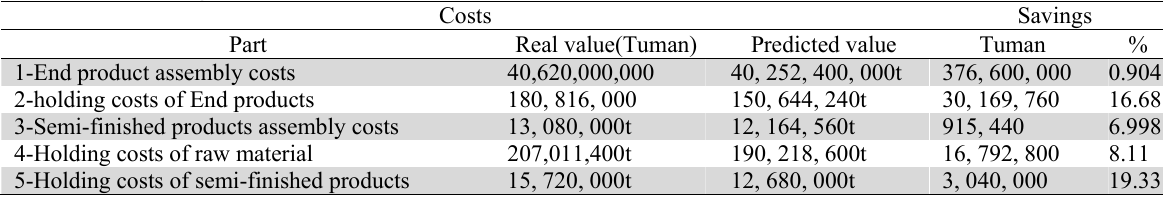
Costs and Savings ( PEUGEOT PARS )